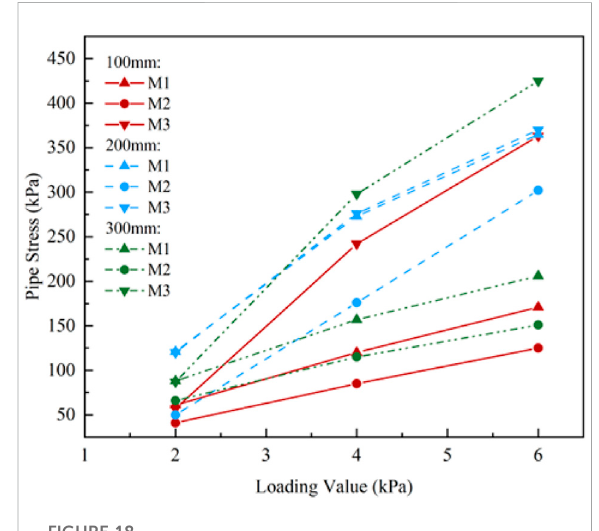
FIGURE 18 Pipeline axial stress of M section at different buried depths.